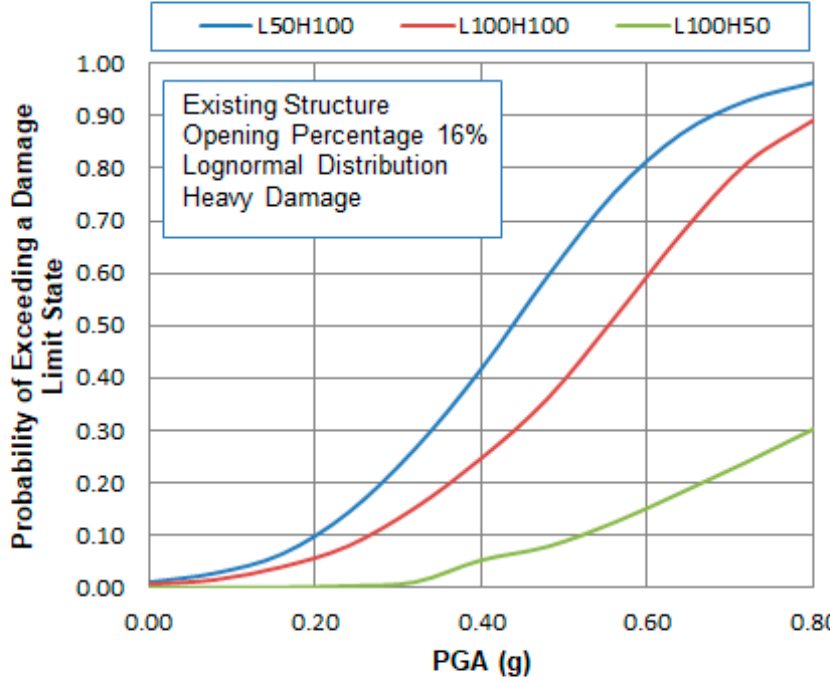
Figure 44. Fragility curves of wall L50H100 in its current condition, for three different walls with an opening percentage of 16%, considering the Syrmakezis et al. (1995) failure criterion [8,25], lognormal distribution and heavy damage performance level.